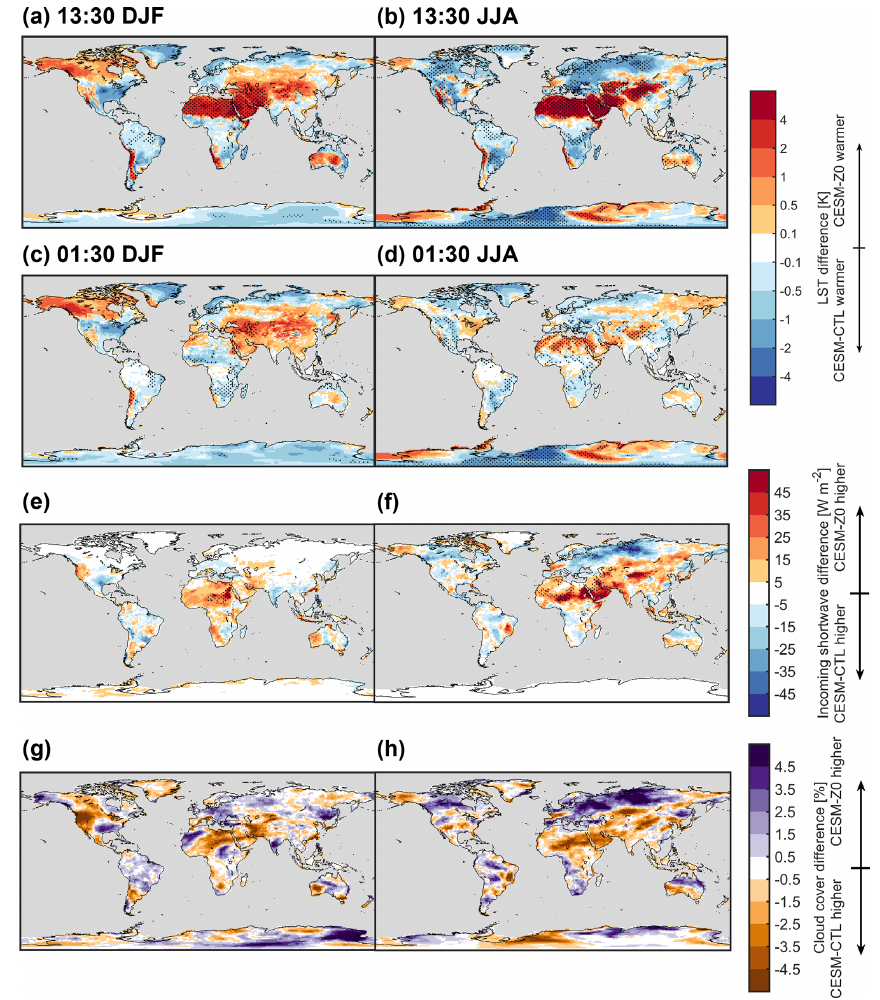
Figure 10. LST difference between CESM-Z0 and CESM-CTL at (a–b) 13:30 local solar time and (c–d) 01:30 local solar time. Panels (e) and (f) show the difference in incoming shortwave radiation at 13:30 local solar time between CESM-Z0 and CESM-CTL, and (g) and (h) show the difference in daily average total cloud cover. The stippling shows areas with a difference that is statistically significant different from 0 in a two-sided t test at the 95% confidence level with a controlled false discovery rate. The left column shows boreal winter (DJF) and the right column boreal summer (JJA). Note the non-linear color scale for panels (a–d)